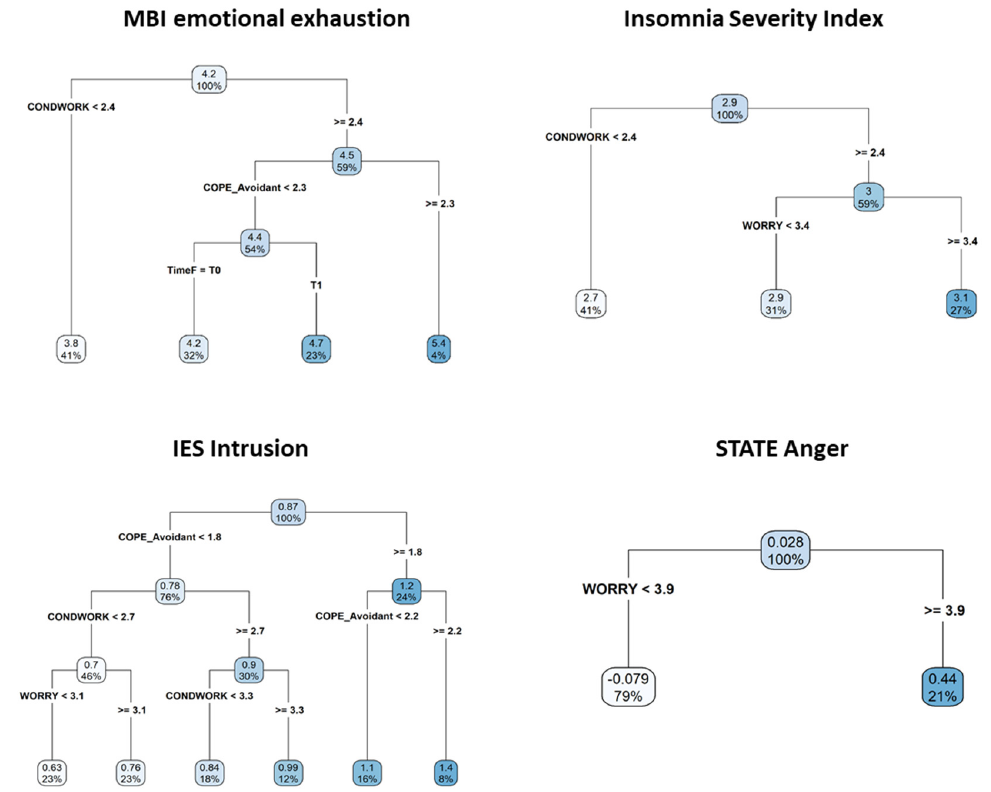
Figure 3. Estimated regression trees for Emotional exhaustion, Insomnia, Intrusion, and State Anger. Square root transformation was applied to the MBI Emotional Exhaustion scale, ISI total score, and IES-R Intrusion scale, while ordered quantile normalization was used for the State Anger scale. Abbreviation: CONDWORK, working conditions.